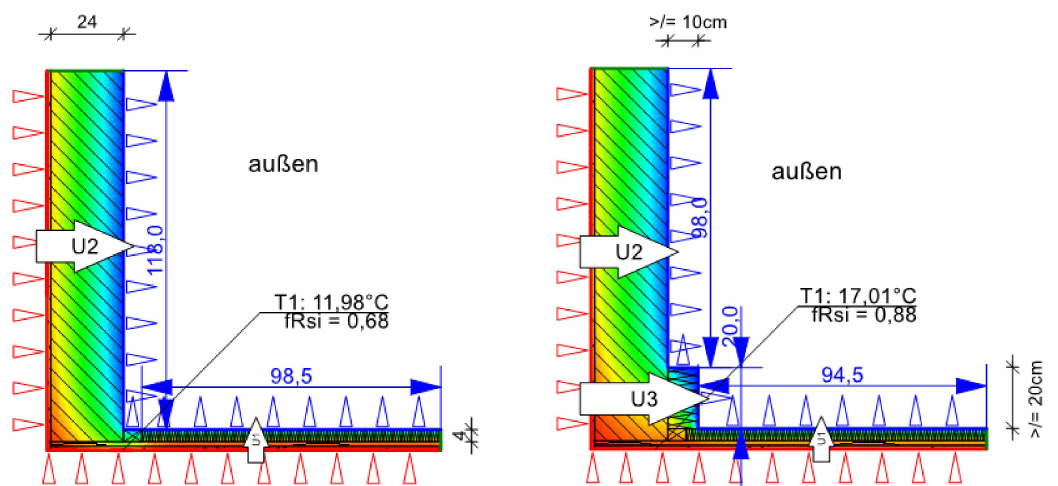
Figure A8. Before and after scheme of the thermal bridge retrofit of a connection between a wall and a rooftop (created with ThermCad thermal bridge simulation